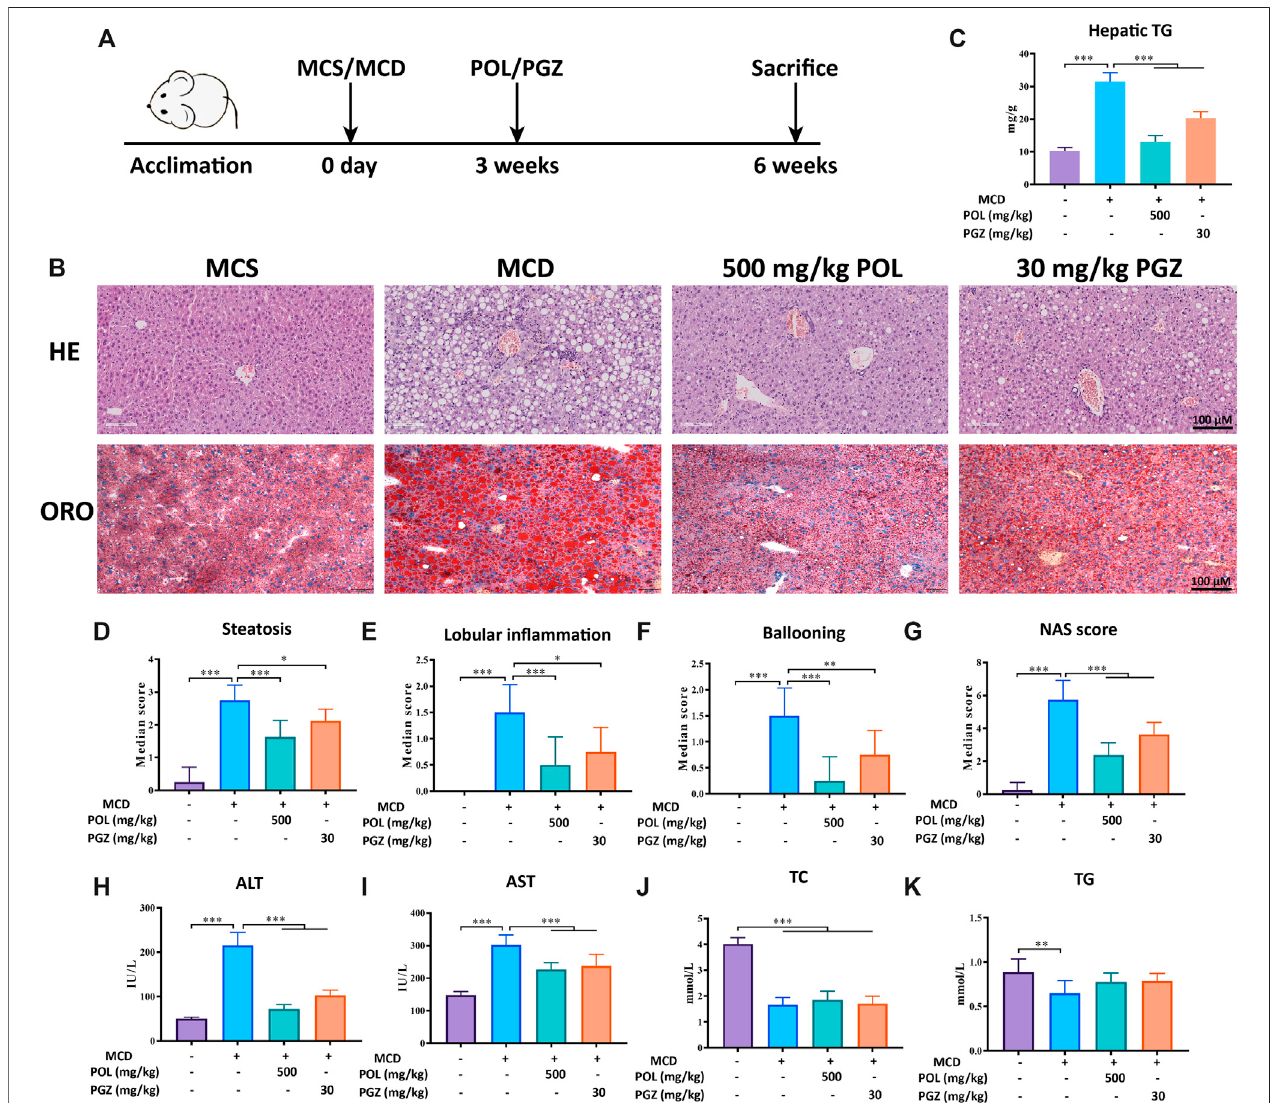
FIGURE1| TheeffectsofPOLinthetreatmentofNASHinMCDdiet-inducedmousemodel.MaleC57BL/6micewerefedwithMCDdietfor6 weekstoestablisha NASH model and treated with 500 mg/kg POL or 30 mg/kg PGZ for 3 weeks (A) . HE and oil red O staining (ORO) were performed to observe the histopathological characteristics of liver tissue after the treatment of POL (B) . Then, the NAS score (G) , including hepatic steatosis (D) , lobular in fl ammation (E) , and ballooning degeneration( F ),werecalculated.Thespeci fi cclassi fi cationcriteriawereasfollows:1)hepaticsteatosis( < 5%,0points;5 – 33%,1point;33 – 66%,2points; > 66%, 3 points); 2) lobular in fl ammation (none, 0 points; < 2 lesions/200 × view, 1 point; 2 – 4 lesions/200 × view, 2 points; > 4 lesions/200 × view, 3 points); and 3) ballooning degeneration (none, 0 points; rare, 1 point; extensive, 2 points). The contents of hepatic TG (C) , serum ALT (H) , AST (I) , TC (J) , and TG (K) were detected. Comparing with model group, * p < 0.05, ** p < 0.01, *** p < 0.001.